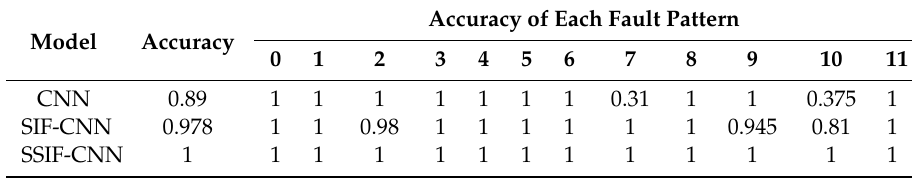
Table 7. The classification accuracy of the testing samples.